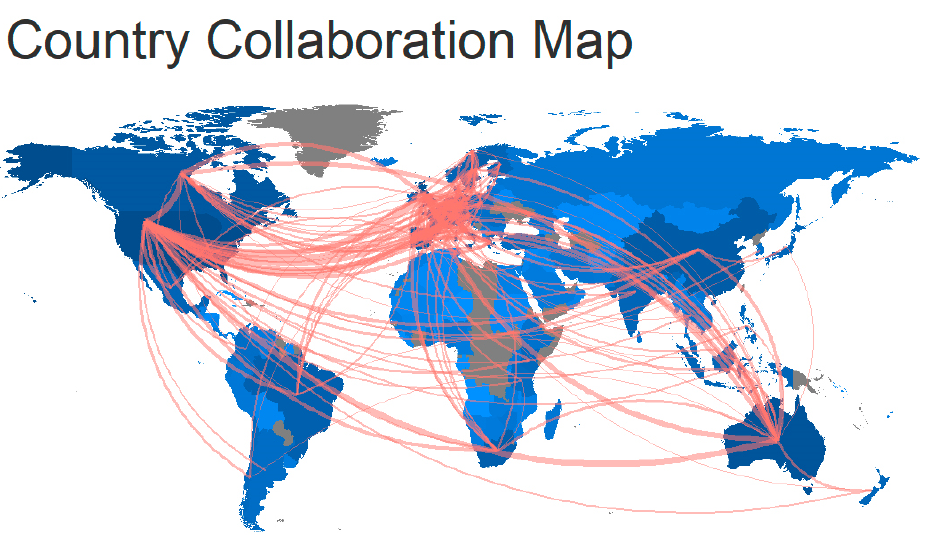
Figure 4. Top 20 countries with the total number of publications on NPAs from 2000 to 2021.